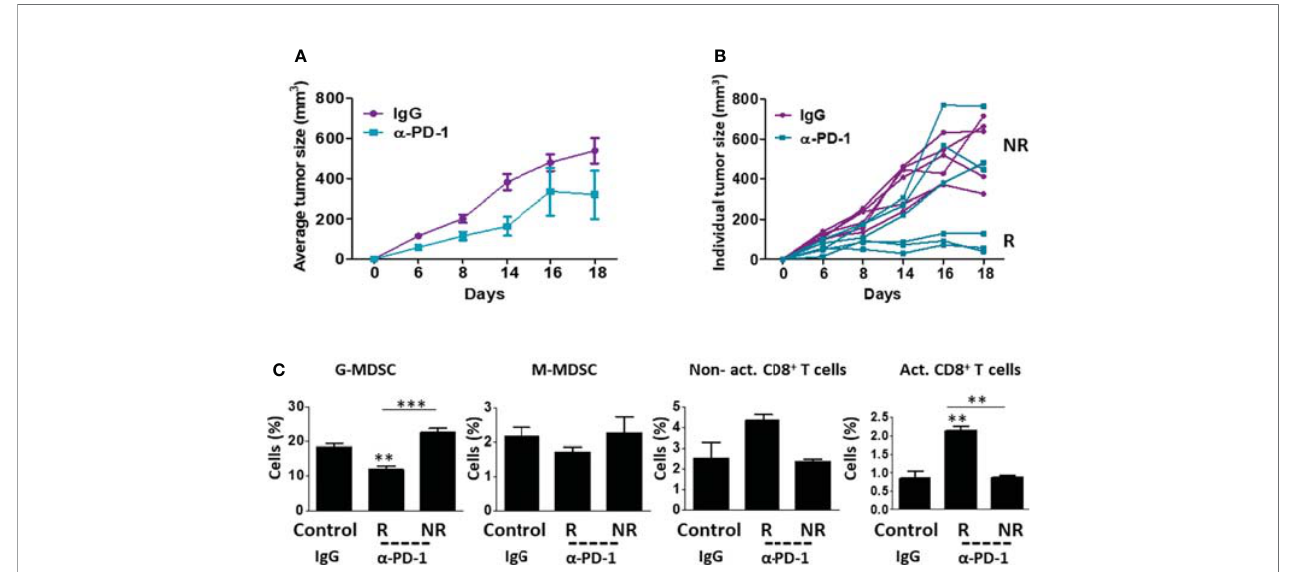
FIGURE 1 | EMT6 tumors exhibit differential response to anti-PD1 therapy. (A, B) Eight-to-ten week old BALB/c mice (n=5-6/group) were implanted with EMT6 cells (5x10 5 /mouse) in the mammary fat pad. When tumors reached 50 mm 3 , treatment with anti-PD1 or IgG control antibodies was initiated twice a week for two weeks. Tumor growth was assessed regularly (A) . At end point, mice were strati fi ed into groups based on their response to treatment. Responders (R) and non-responders (NR) are shown in the spider plot (B) . (C) Tumors from control mice (IgG) and anti-PD1-treated responder (R) and non-responder (NR) mice were removed and prepared as single-cell suspensions. Granulocytic and monocytic MDSCs (G-MDSC and M-MDSC, respectively) as well as non-activated and activated CD8+ T cells were quanti fi ed using fl ow cytometry and presented as the percentage from CD45+ cells. The average percentage ± SD for each cell type is shown in a bar graph. Statistical signi fi cance was assessed by one-way ANOVA followed by Tukey post-hoc test. Signi fi cant p values are shown as **p<0.01 and ***p<0.001 from control or otherwise indicated in the fi